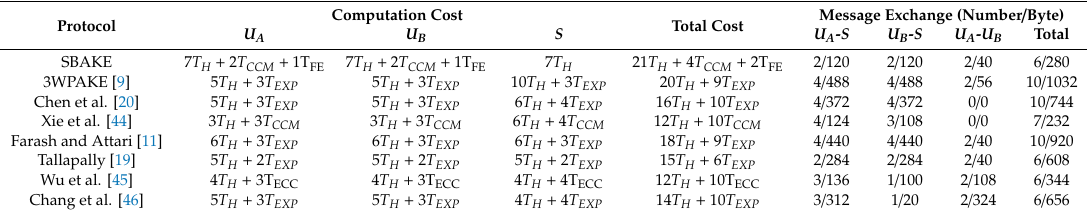
Table 4. Performance comparison for the login and authentication